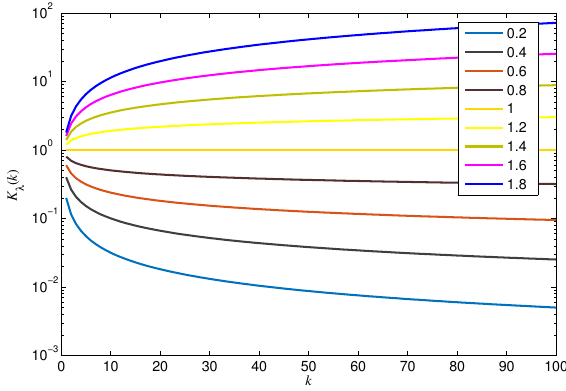
Figure 1. Curves of K λ ( k ) with different orders λ